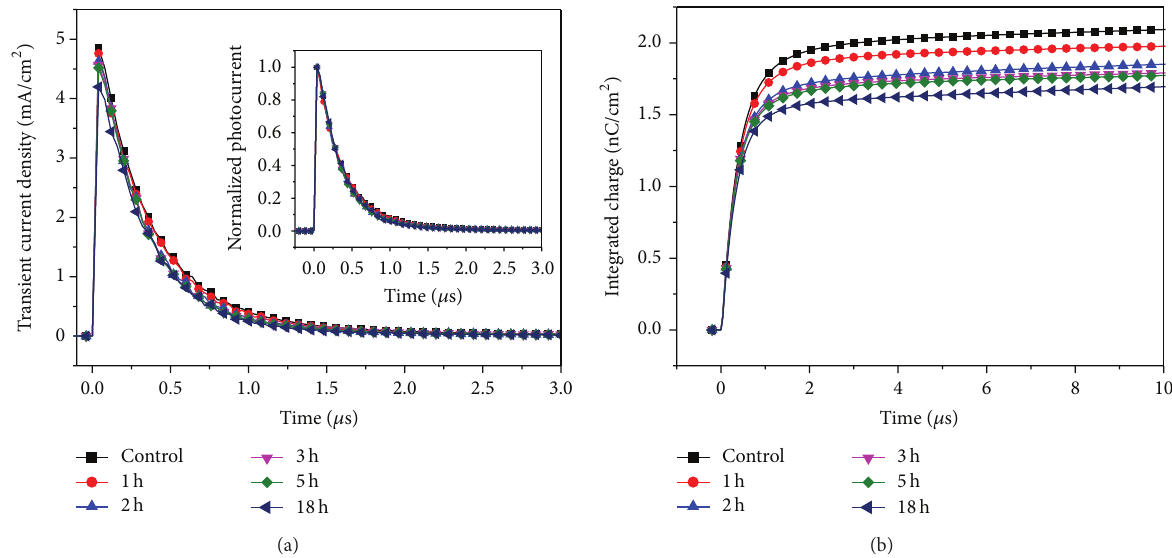
Figure 6: (a) Decay of the transient photocurrent density 𝐽 and normalized 𝐽 (insert) of control device and the devices thermally treated at 70 ∘ C for different time. (b) Total swept-out charge density as a function of decay time for solar cells.